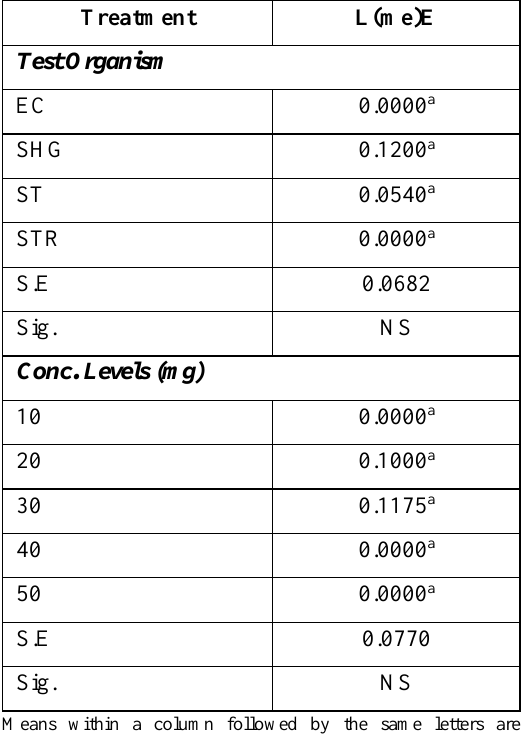
Table 9. The minimum inhibitory concentration of methanolic leave extracts of Moringa oleifera on test